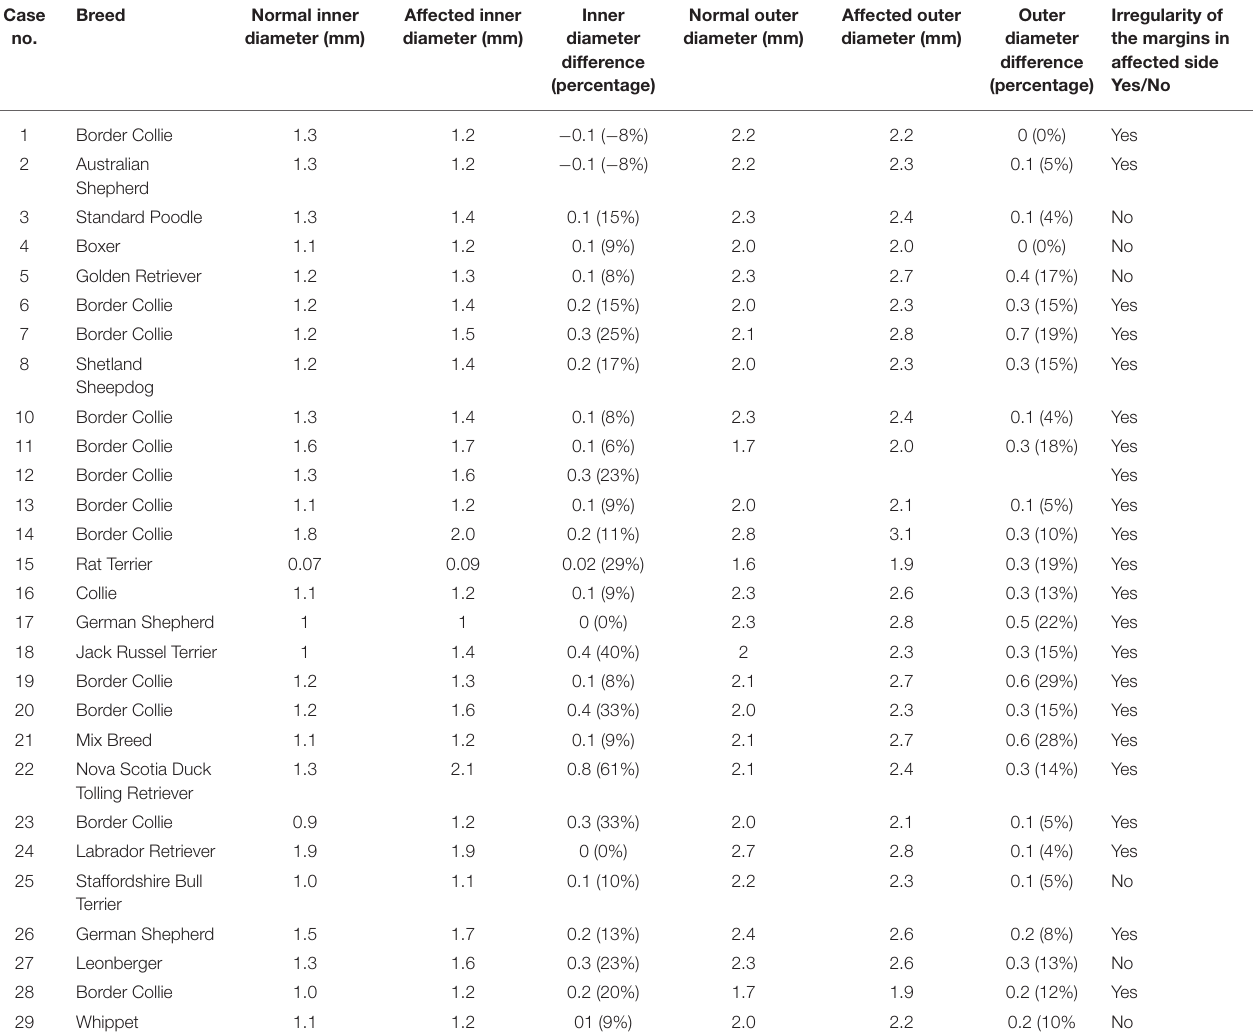
TABLE 2 | Ultrasonographic findings and measurements of the sciatic nerves. Case